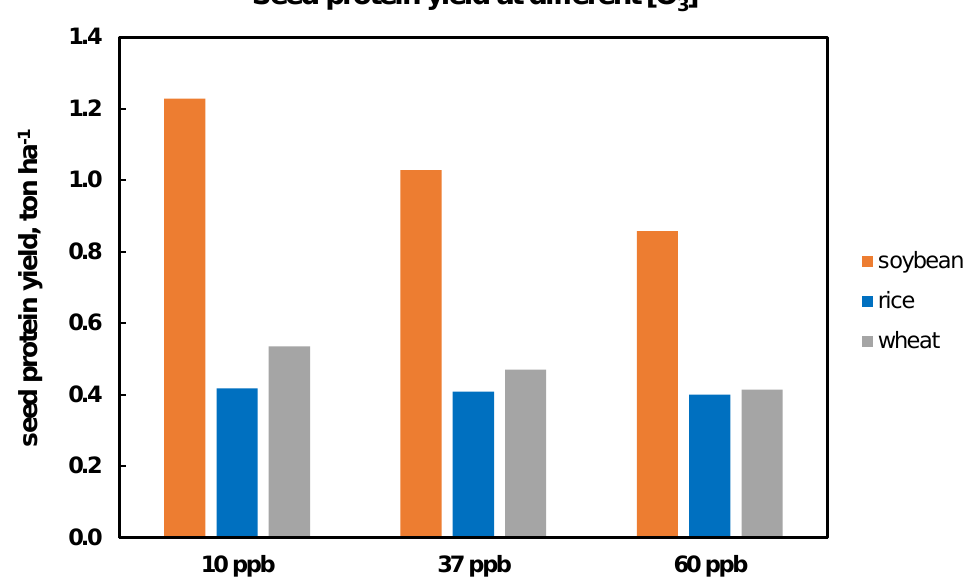
Figure 5. Estimation of the typical seed protein yield (SPY) based on FAO statistics for global average yields and the response functions of the present study for three O 3 concentration scenarios: preindustrial O 3 (10 ppb), the average O 3 levels of the control treatments in the experiments (37 ppb), and a hypothetical future increased [O 3 ] at 60 ppb.